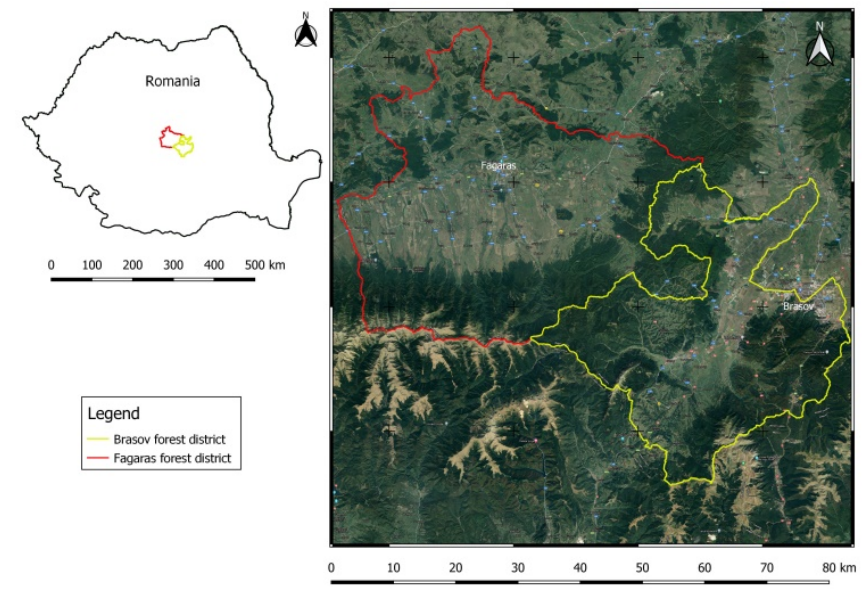
Figure 1. Location of forest management units.